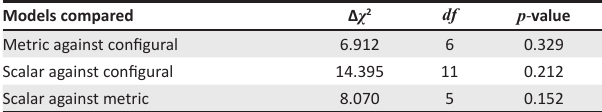
TABLE 5: Results of the invariance testing based on media use.